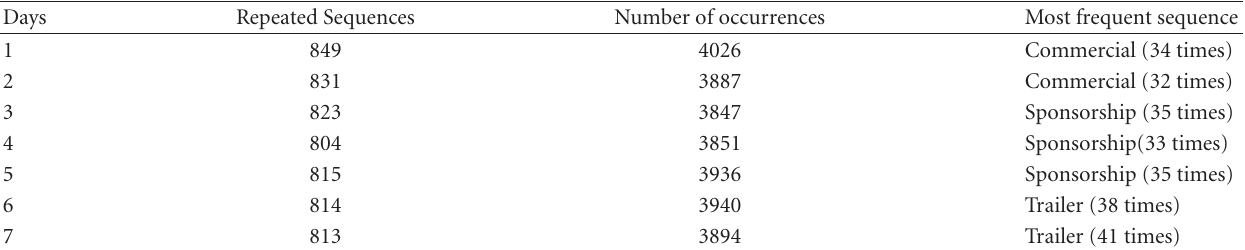
Table 4: Detected repeated sequences on each day of TVTest . For each day, a sliding accumulated TV stream of 7 days has been taken into account.